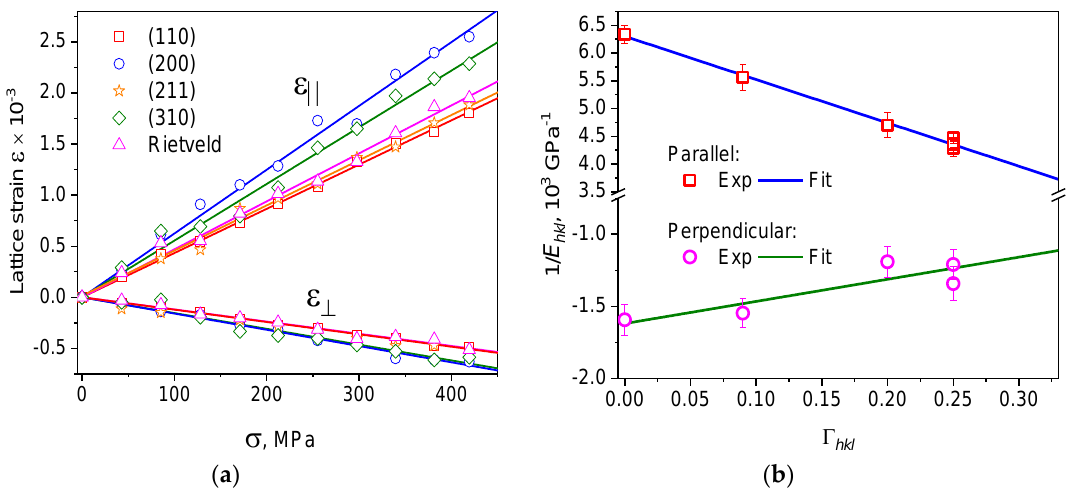
Figure 18. ( a ) Longitudinal and transverse lattice strain of ferrite steel vs. applied load for different crystal planes. ( b ) Inverse values of longitudinal and transverse Young’s moduli vs. anisotropy (orientation) factor Г hkl , adapted from [19], with permission from © 2018 Springer.